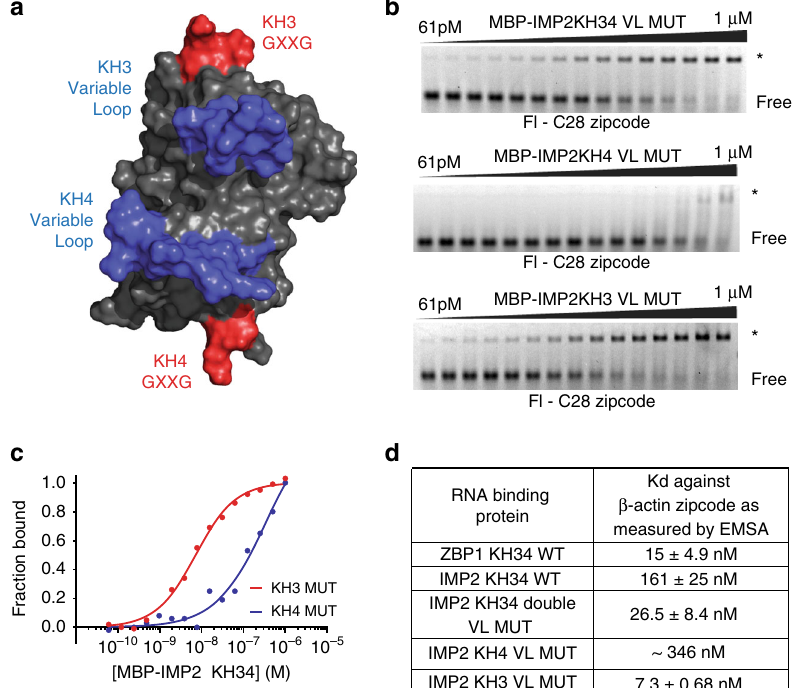
Fig. 4 Mutations of the KH3 variable loop are suf fi cient to determine RNA-binding. a Surface rendering of IMP2KH34 shows putative binding site of RNA with variable loops in blue and GXXG motifs in red. b Top: double loop replacement allows for IMP2 to now bind to the ß-actin zipcode. Middle: the KH4 loop swap by itself does not increase af fi nity to the ß-actin zipcode compared to WT IMP2KH34. Bottom: KH3 variable loop replacement is suf fi cient to swap the speci fi city of IMP2KH34 and allow it to bind to ß-actin zipcode. c Quanti fi cation and fi t to the Hill equation of top and middle representative EMSA results (in b ) for IMP2KH3 VL MUT (solid red line) and IMP2KH4VL MUT (solid blue line) binding to ß-actin zipcode. d Dissociation constants ( K d ) of ZBP1KH34 WT (gel in Fig. 1c), IMP2KH34 WT (gel in Fig. 1c), and the IMP2 variable loop mutants (i.e., KH34 double VL MUT, KH3 VL MUT, and